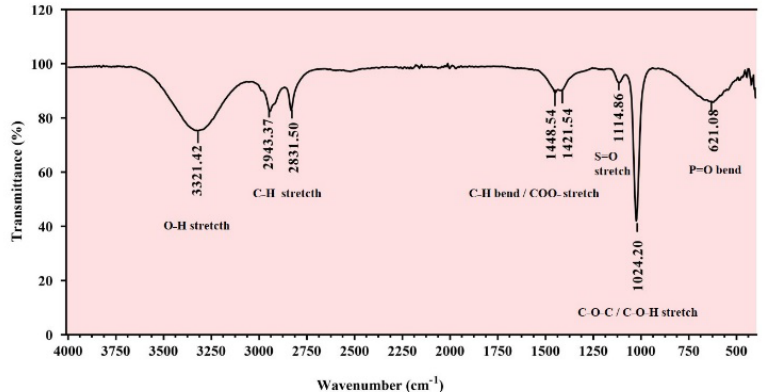
Figure 3. Infrared spectra of Virgibacillus dokdonensis VITP14 exopolysaccharide (EPS).